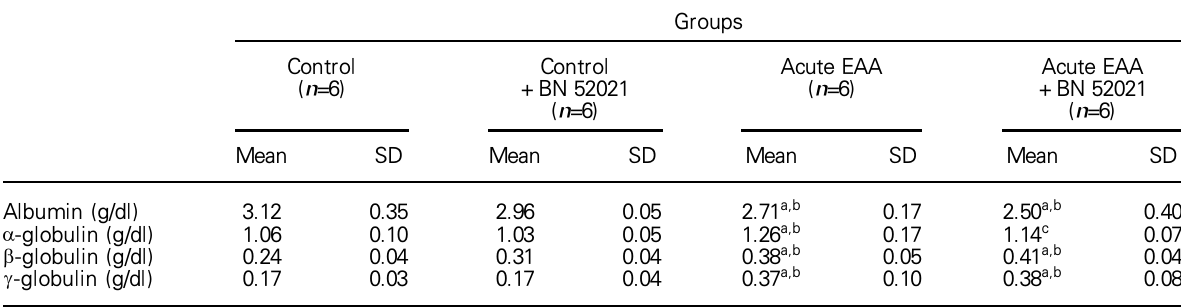
Table 3. Electrophoretic serum protein profile